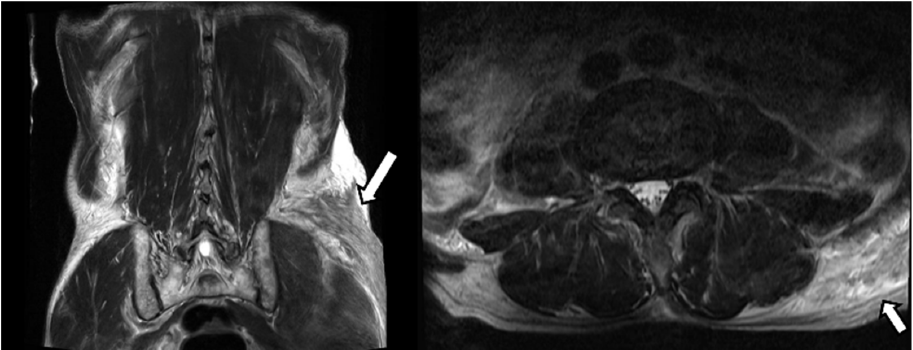
Figure 1. Magnetic resonance imaging (MRI) of the buttock. MRI revealed a well-defined mass in the left buttock. The mass showed a heterogeneously higher signal intensity than the skeletal muscle on T2-weighted